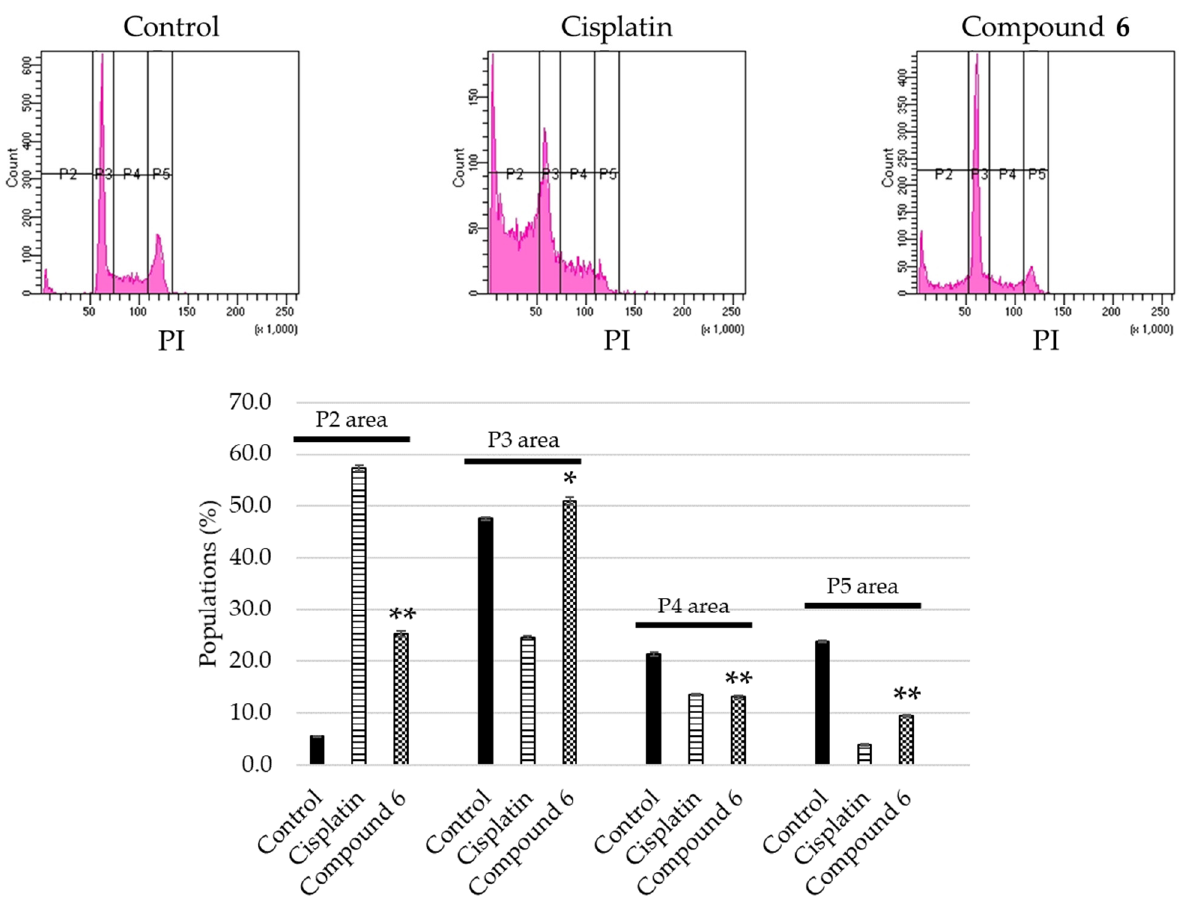
Figure 7. Cell cycle progression for HL-60 cells treated with cisplatin or 6 . Top: HL-60 cells were treated with either 20 μ M of cisplatin or 40 μ M of 6 for 24 h, and the cell cycle distribution was analyzed by flow cytometry. Bottom: percentage of cells in the sub-G 1 (P2 area), G 0 /G 1 (P3 area), S (P4 area), and G 2 /M (P5 area) phase are exhibited as mean ± S.E.M. of three experiments (** p < 0.001, * p < 0.05 vs. control group).